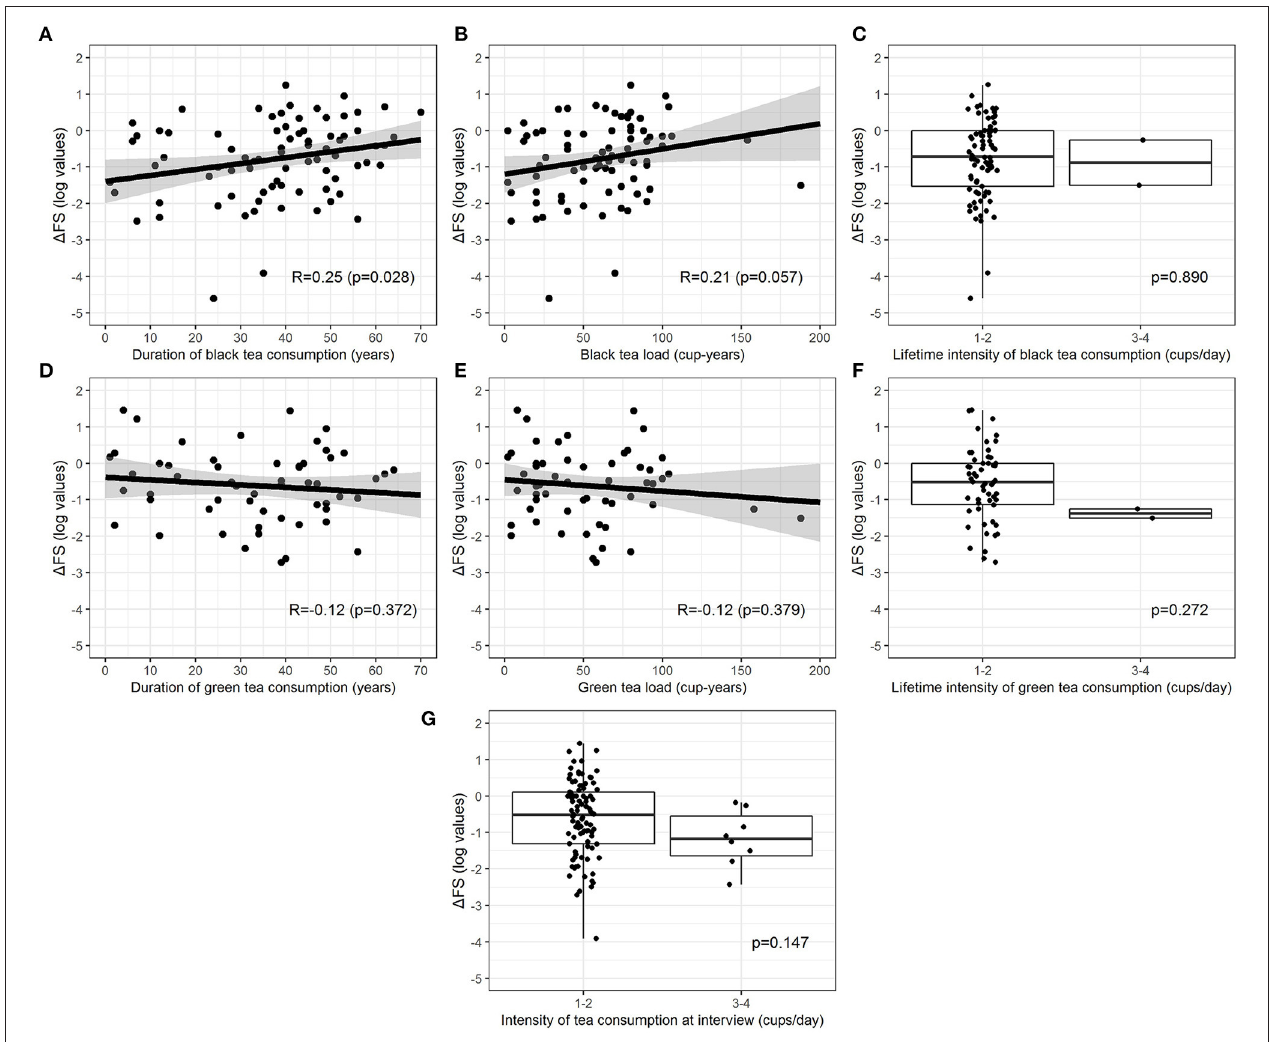
FIGURE 2 | Relationship between log-transformed 1 FS and duration of consumption (A,D) , lifetime load (B,E) , and lifetime intensity (C,F) for green and black tea (current and former consumers). Relationship between log-transformed 1 FS and intensity at the interview for all types of tea combined (G) (only current consumers). The relationship between continuous exposures and log-transformed 1 FS is graphically represented by a scatterplot with a fitted regression line, along with estimated Pearson correlation coefficient ( R ) and p -value, whereas the association between categorical exposures and log-transformed 1 FS is graphically represented by a boxplot, along with p -values from the two-sample t